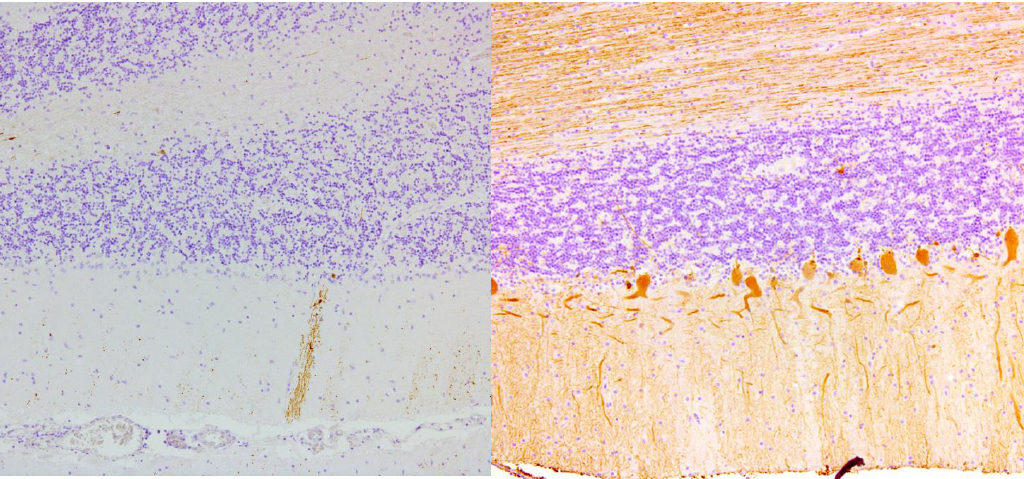
Figure 2. Complete loss of Purkinje cells in the cerebellar cortex of a gluten ataxia patient (left). Normal cerebellum from a control patient on the right shows the single layer of Purkinje cells (calbindin and hematoxylin staining, magnification 100x).